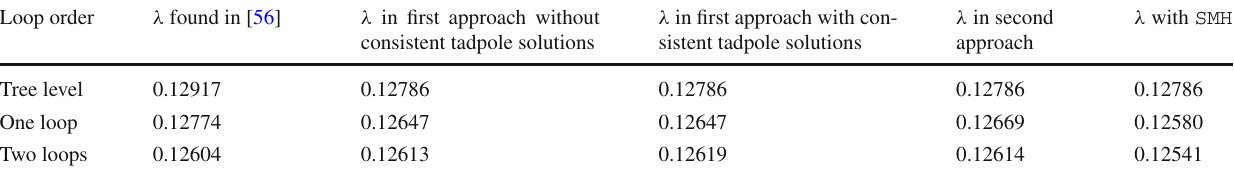
Table 2 Values of the Higgs quartic coupling λ extracted from m h = 125 . 15 GeV, at tree level, one loop and two loops. The methods we used